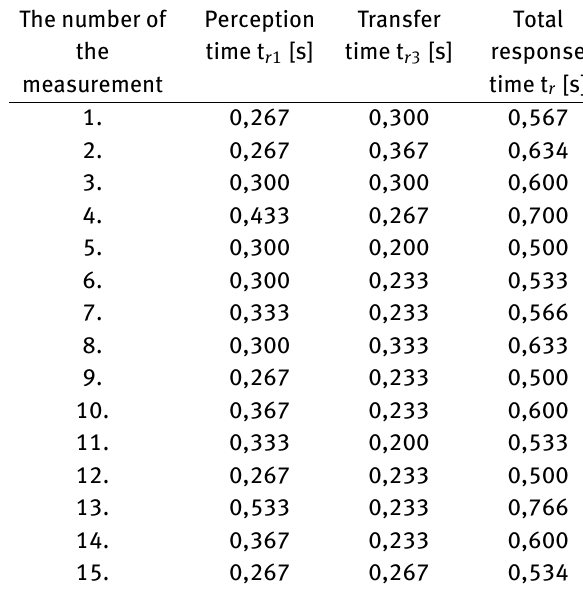
Table 13: Summary of the results of driver H. The number of Perception the measurement